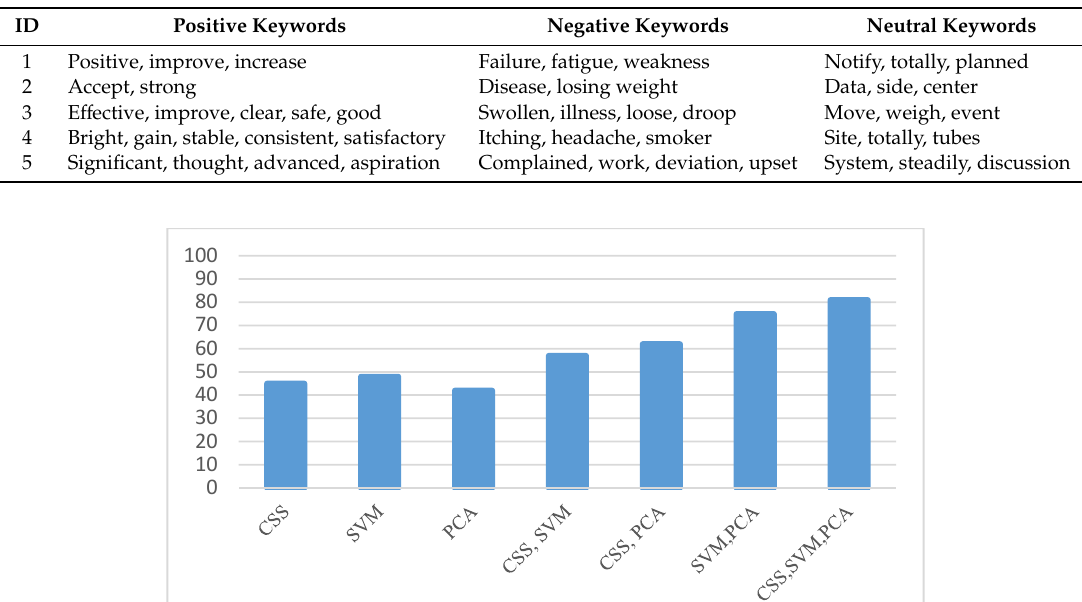
Table 3. The positive, negative and neutral keyword list for each discharge summaries.